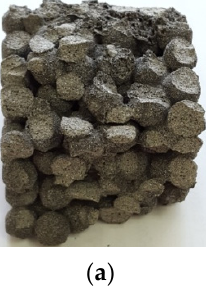
Figure 14. Appearance of composite material samples after testing: ( a ) after compression test; ( b ) destruction of a multilayer sample; ( c ) before testing for thermal resistance; ( d ) after 25 thermal cycles of thermal resistance tests.